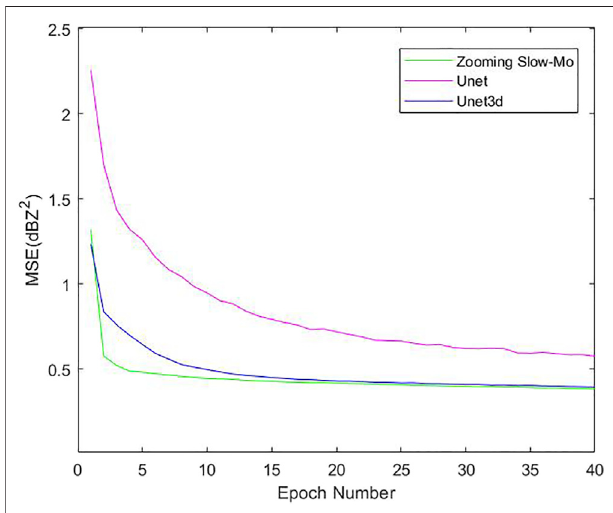
FIGURE 7 | Loss function curve of three different deep learning methods.